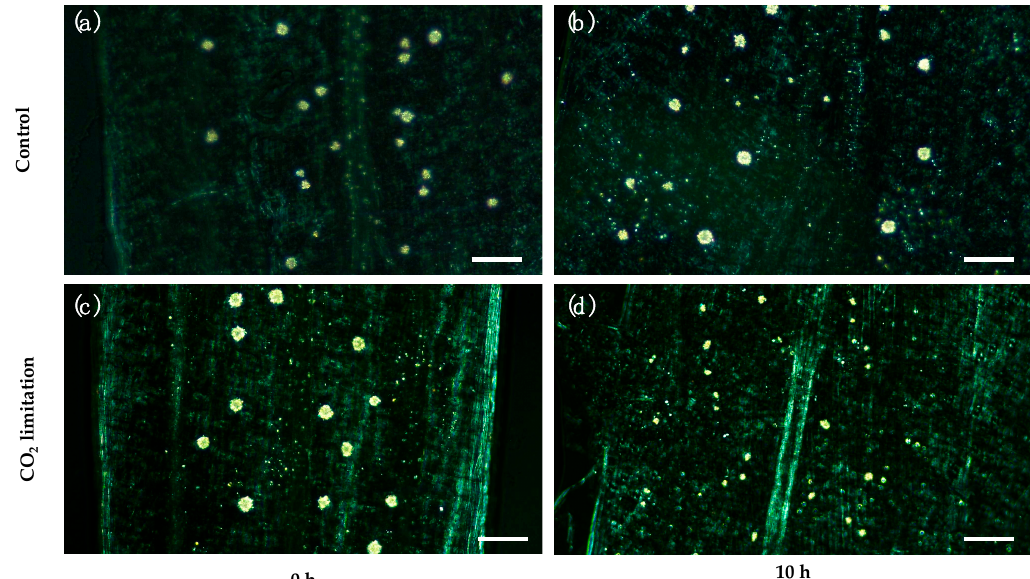
Figure 2. Paradermal view of the chlorine ‐ bleached leaves under polarized light. CaOx crystals are visible as bright spots. Note the obvious differences in size and distribution of crystals between 0 h and 10 h under CO 2 limitation. ( a ) Control leaf, time = 0 h, 400 ppm CO 2 . ( b ) Control leaf, time = 10 h, 400 ppm CO 2 . ( c ) Treatment leaf, time = 0 h, 11.5 ppm CO 2 . ( d ) Treatment leaf, time = 10 h, 11.5 ppm CO 2 . Bars = 200 μ m.